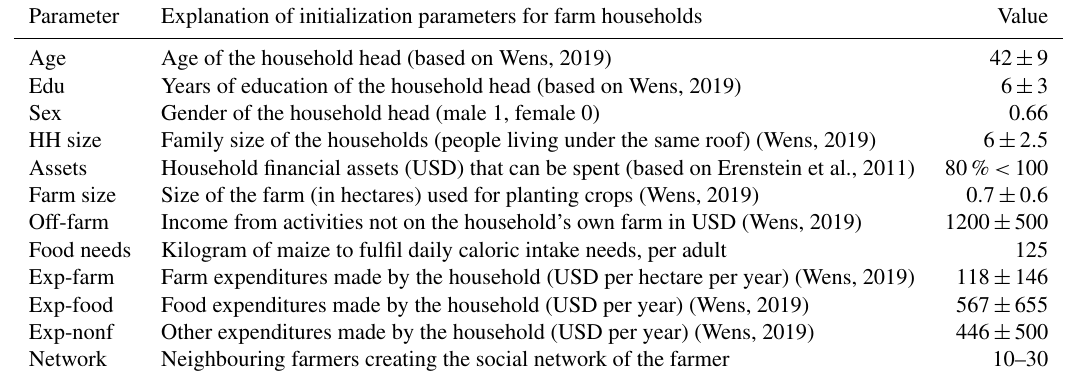
Table A1. Initialization parameters for farm households in ADOPT. Parameter